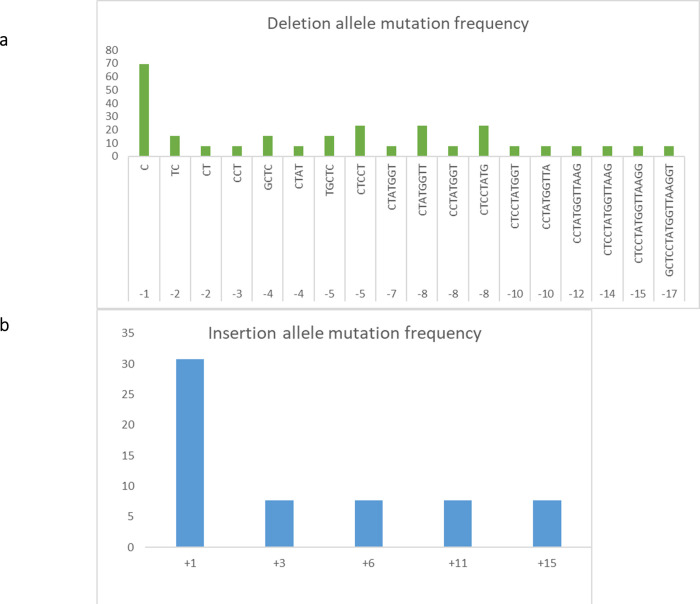
Frequency of deletion (a) and insertion (b) mutations observed among the thirteen T0 lines.